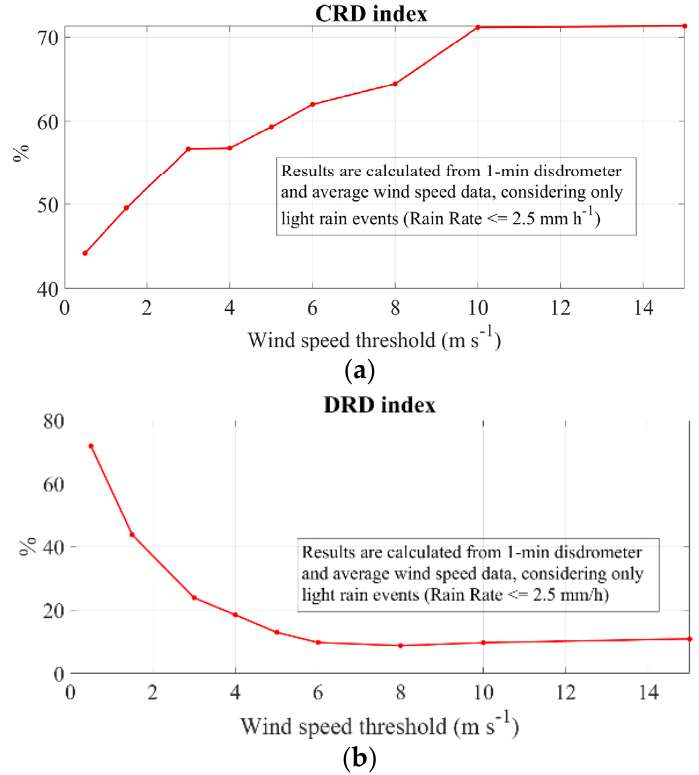
Figure 8. Methods to quantify the wind effect on the Thies spectrograph. The panel ( a ) sketches the CRD indicator, i.e., the combinations of velocity-diameter classes differing more than 50% with the theoretical fall velocity [33]. In ( b ), the DRD indicator, i.e., particles found within a region close (±50%) to the theoretical line, is shown. Both quantities are expressed in percentages and have been computed for the nine wind speed classes presented in Table 3.